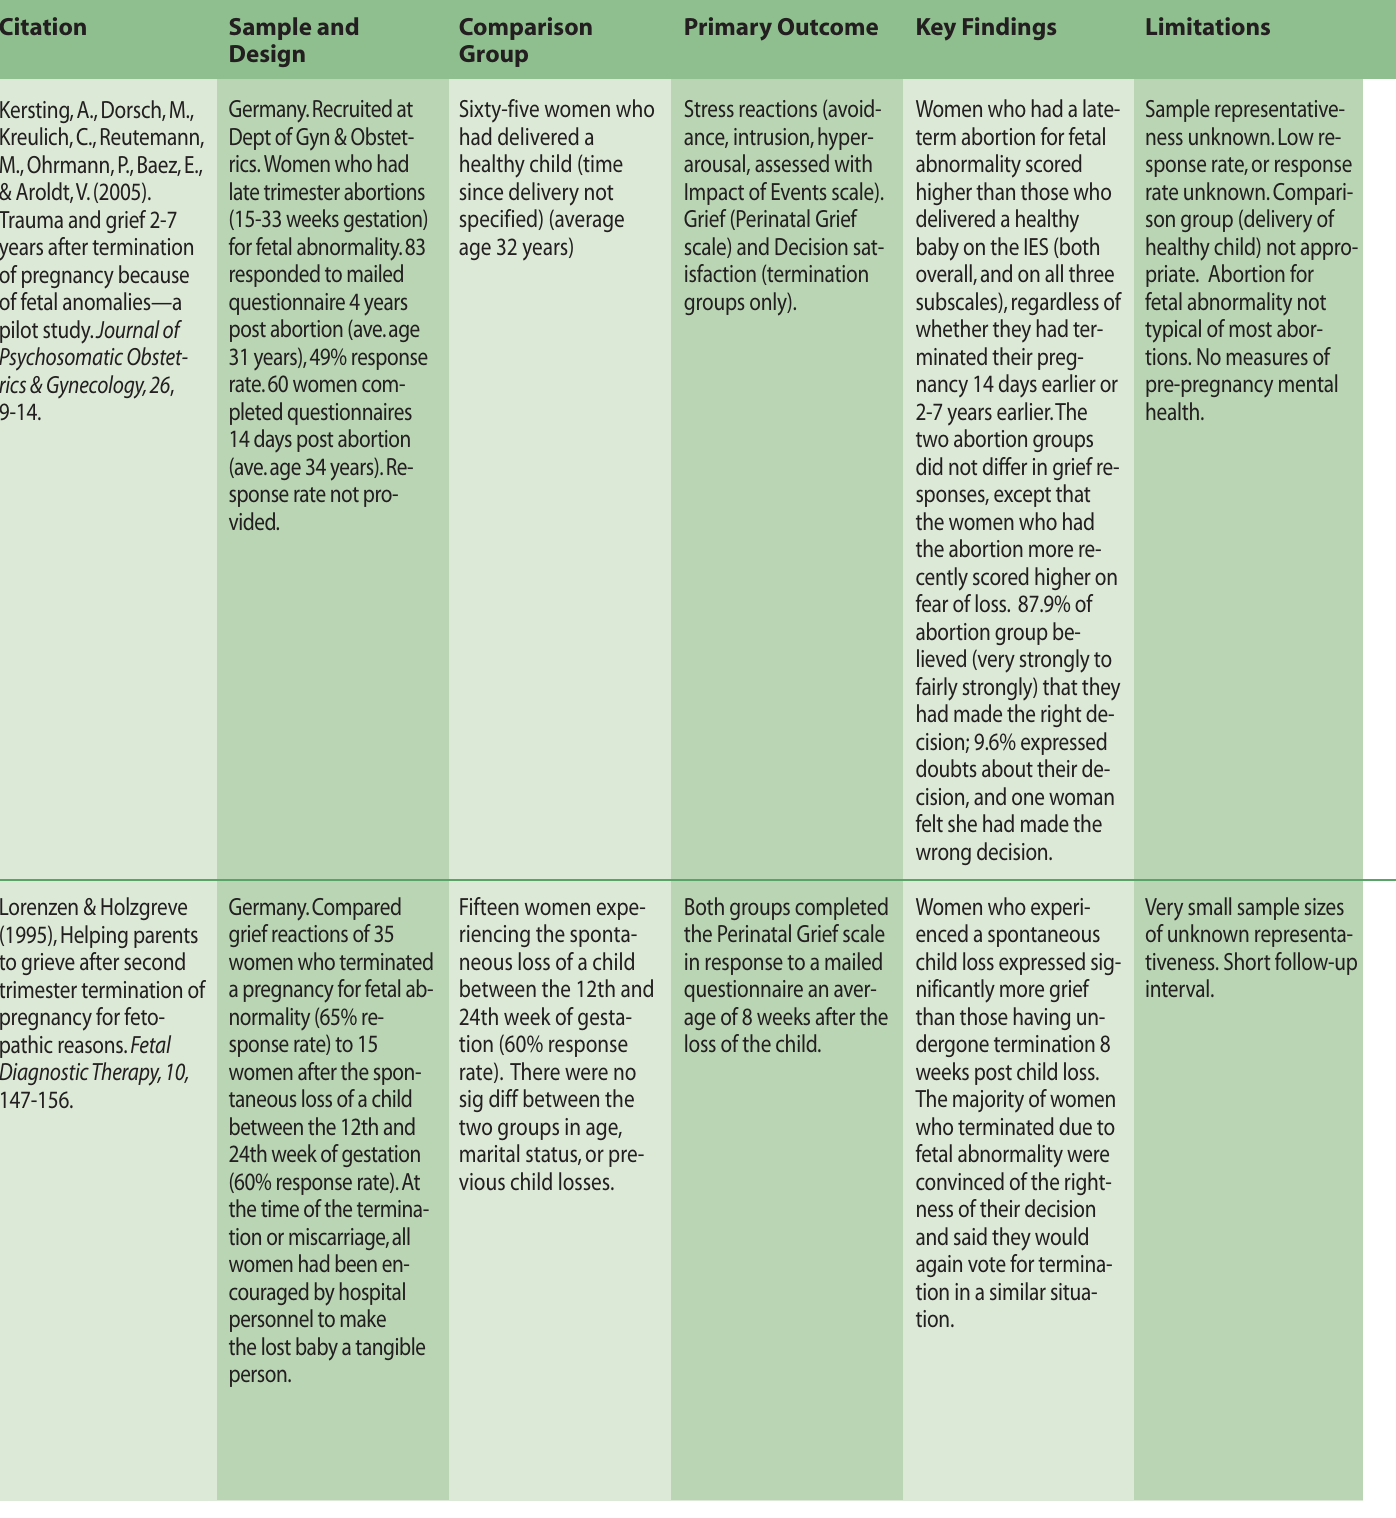
Table 4: Abortion for Reasons of Fetal Anomaly (continued)